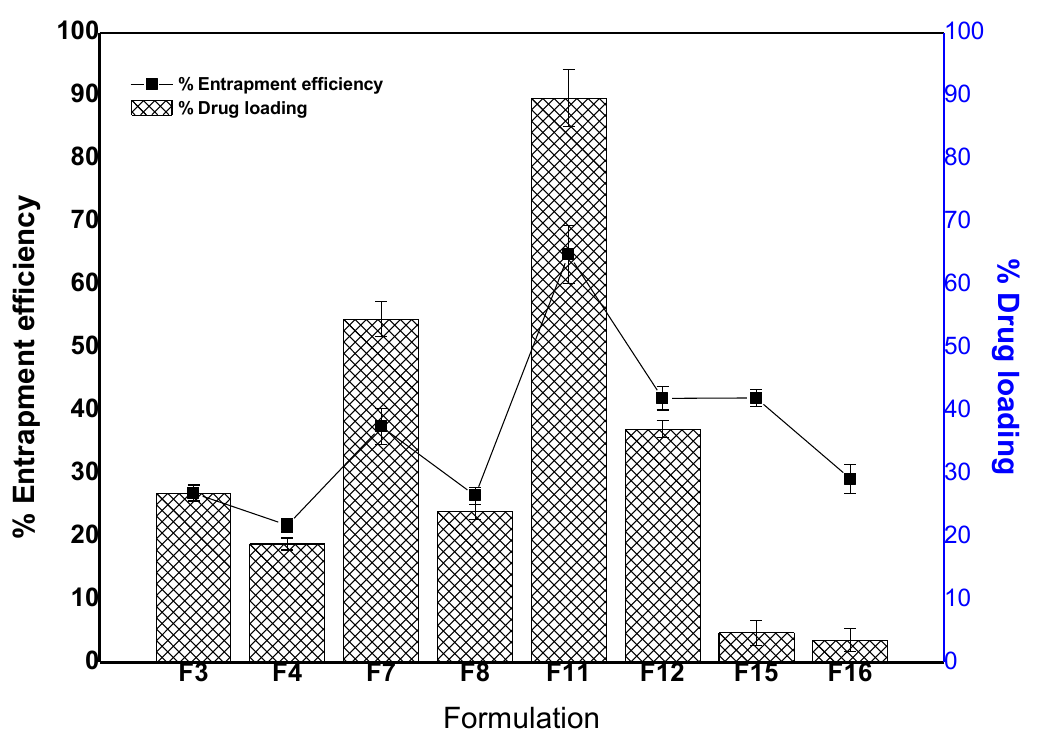
Figure 2. Drug loading and entrapment efficiency (%) of the selected. Data presented as mean ± Figure2. Drugloadingandentrapmente ffi ciency(%)oftheselected. Datapresentedasmean ± standard standard deviation ( n = 3). deviation ( n =